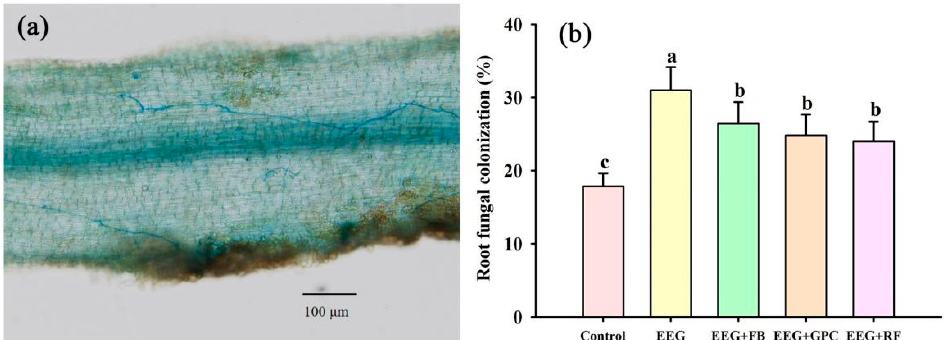
Figure 1. Root AMF colonization ( a ) and effects of foliar spraying easily extractable glomalin-related soil protein in combination with agronomic strategies on the root AMF colonization rate ( b ) of Satsuma mandarin “Oita 4” trees. Data (means ± SD, n = 4) are significantly ( p < 0.05) different if followed by different letters above the bars. Abbreviations: Control, the trees in which no external treatments were applied; EEG, the trees in which easily extractable glomalin-related soil protein was applied; EEG+FB, the trees in which easily extractable glomalin-related soil protein was applied in combination with fruit bagging; EEG+GPC, the trees in which easily extractable glomalin-related soil protein was applied in combination with grass-proof cloth mulching; EEG+RF, the trees in which easily extractable glomalin-related soil protein was applied in combination with reflective film mulching.